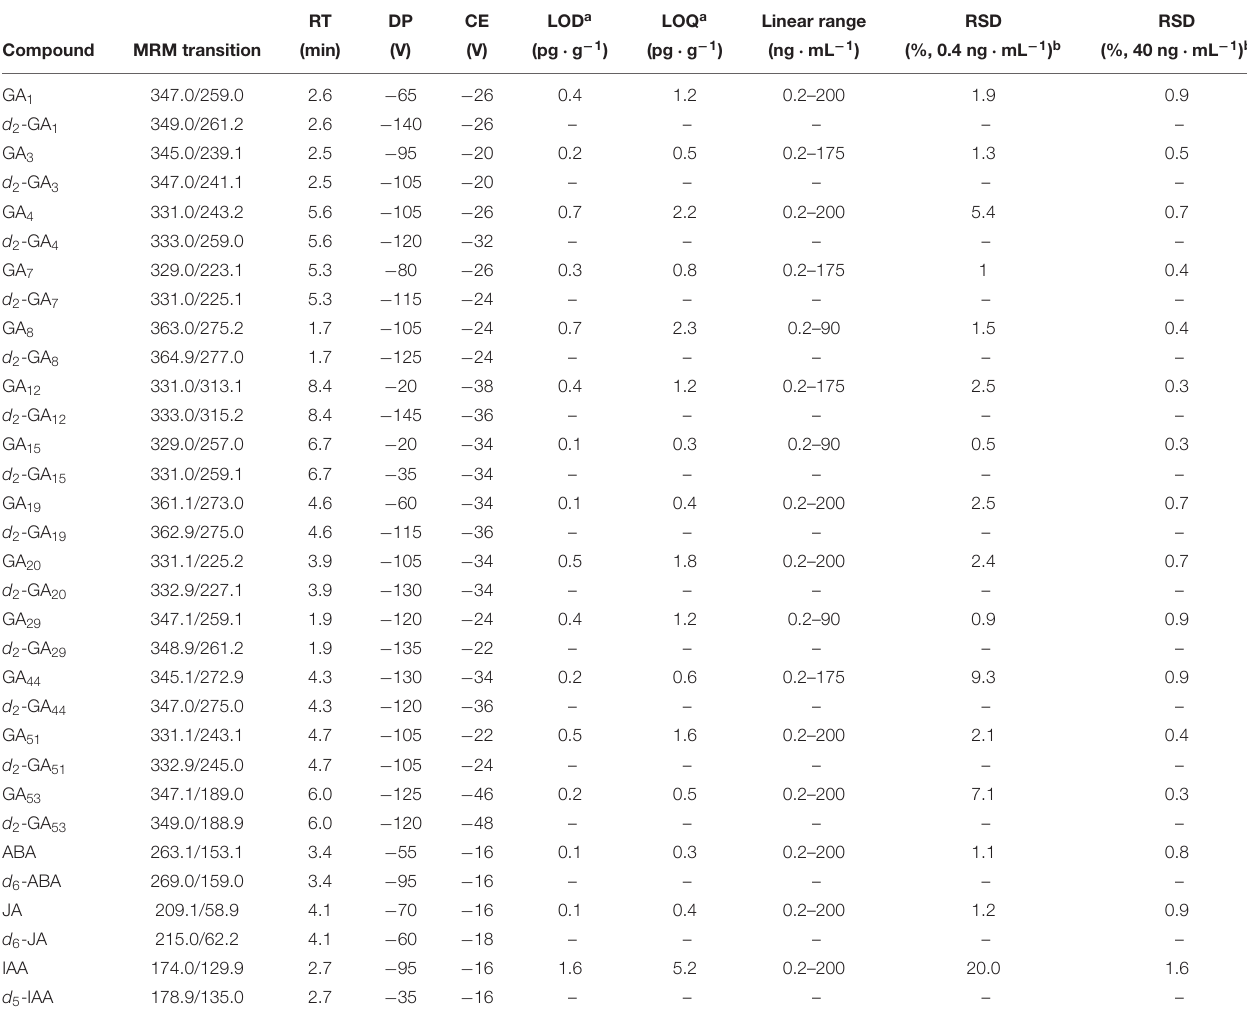
TABLE 3 | Multiple reaction monitoring transitions, retention time (RT), declustering potential (DP), collision energy (CE), limit of detection (LOD) and limit of quantification (LOQ) for the phytohormones analyzed in method HPLC-2 (6500QTRAP). RT DP CE LOD a LOQ a Linear range RSD